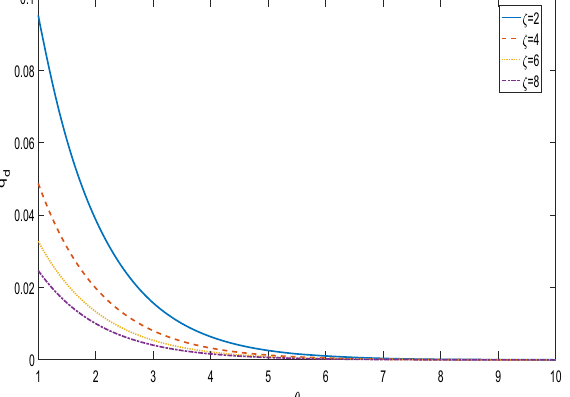
Fig. 8 Dimensionless discharge w.r.t. dimensionless time for η = 10 , ζ = 2 , 4 , 6 , 8 and fractional order α = 0 . 90 , β = 0 .